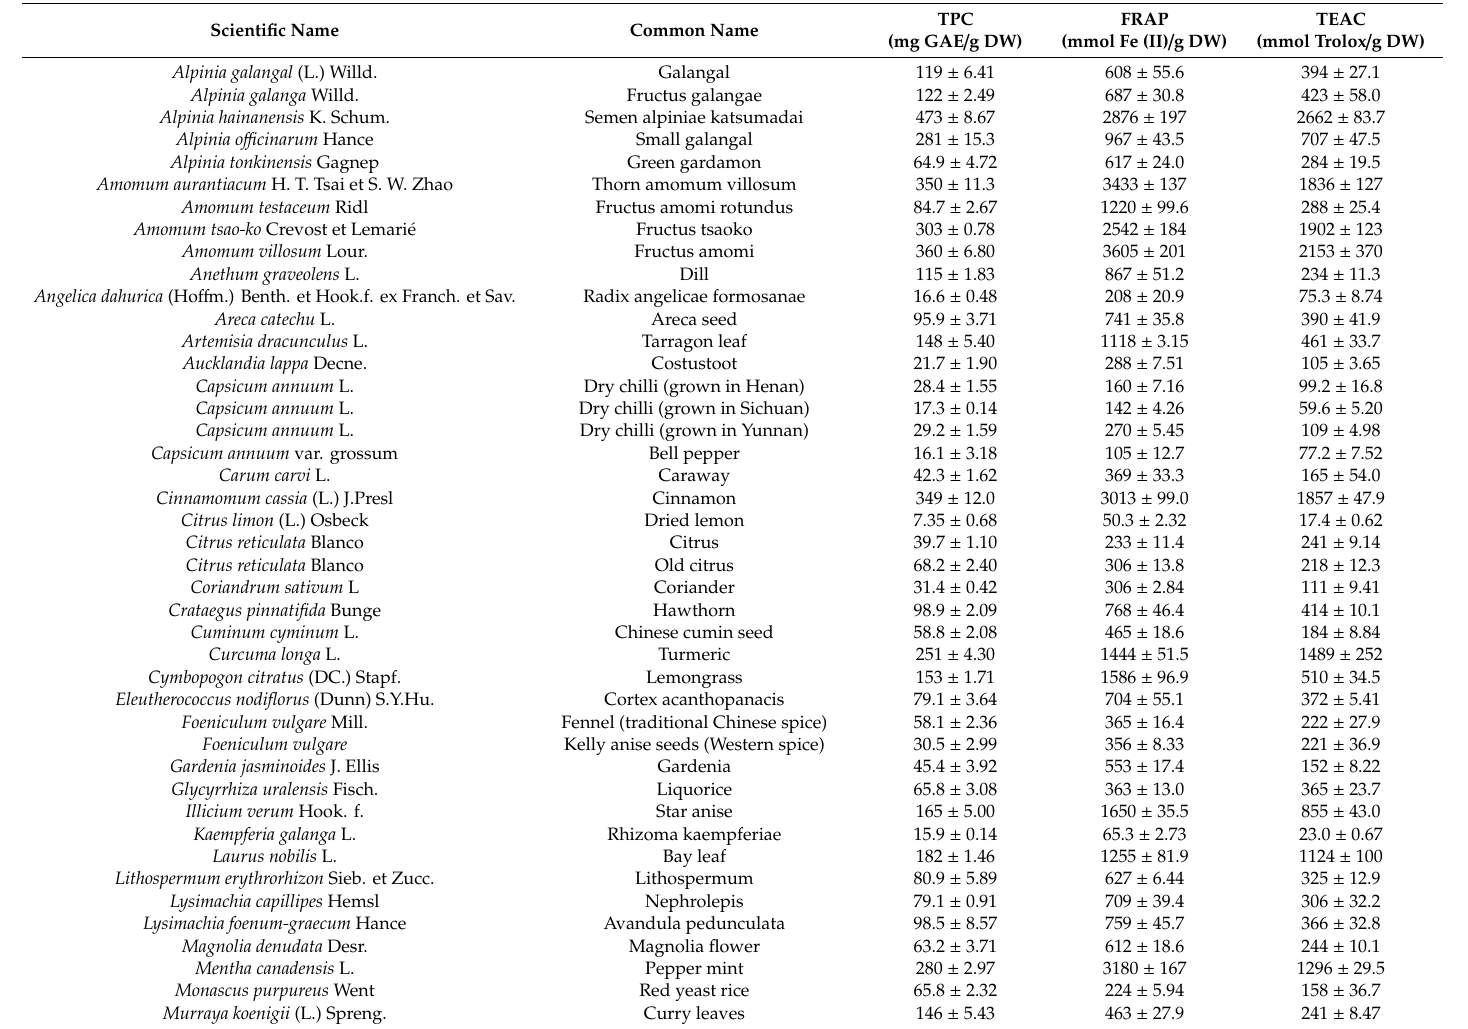
Table 4. Antioxidant activity and total phenolic content of 67 spice